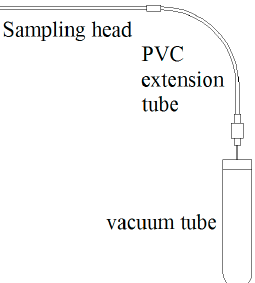
Figure 2. Structure of the Rhizon pipes.